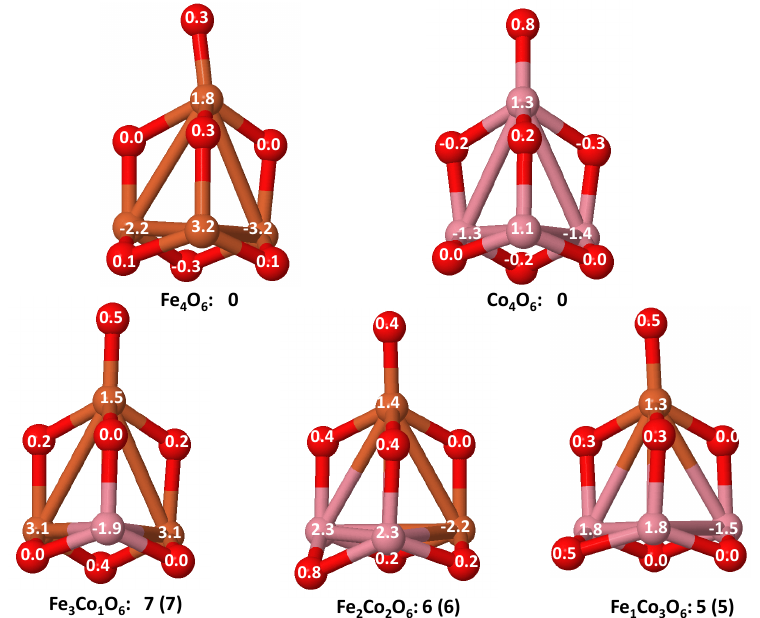
Figure 15. (Color online) Ground states of Fe 4 − x Co x O 6 ( x = 0–4) oxides. Local magnetic moments of Fe, Co and O atoms are indicated. Positive (negative) numbers indicate spin up (down). Below each of the structures, total magnetic moment is given. Numbers between parentheses are the values of the magnetic excess. Both quantities are in µ B units. Fe atoms in brown color, Co atoms in pink and oxygen atoms in